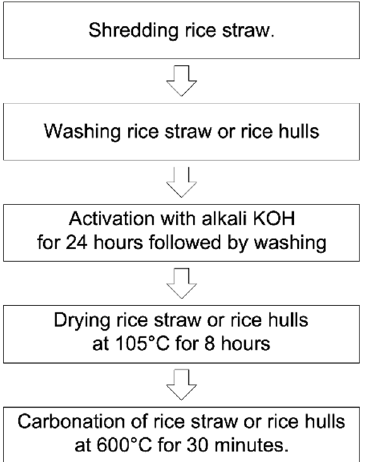
Figure 1. Method for obtaining carbonized rice straw (rice husk).